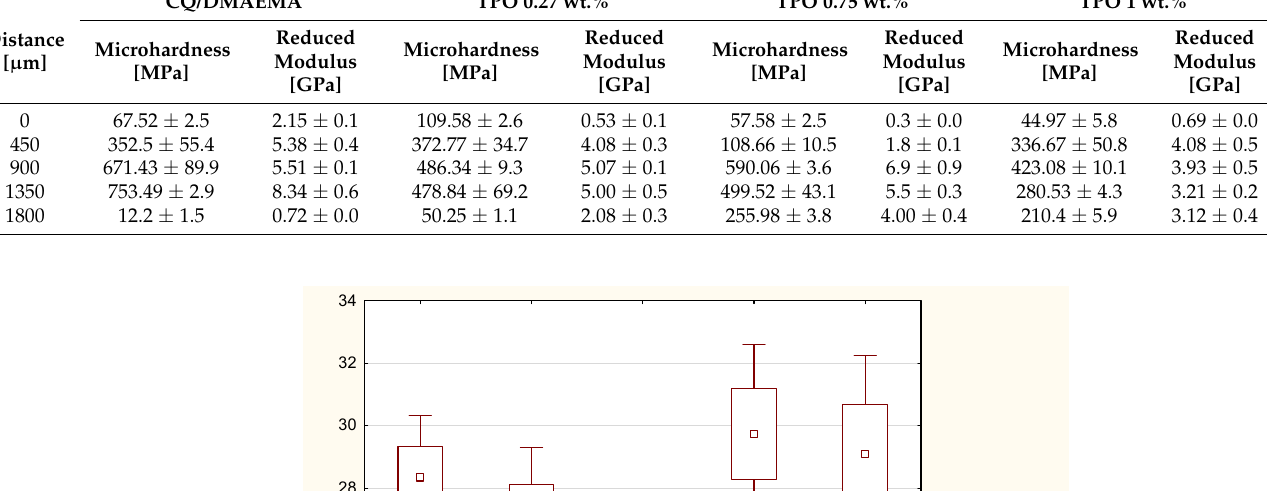
Table 2. The average results for microhardness (MPa) and reduced modulus (GPa) with standard deviations. The results were determined by nanoindentation of the top (0 µm), bottom (1800 µm), and cross-section (450, 900 and 1350 µm) of tested material samples; photopolymerization one side 20 s per 2 mm with Valo lamp light intensity 1450 mW/cm 2 .